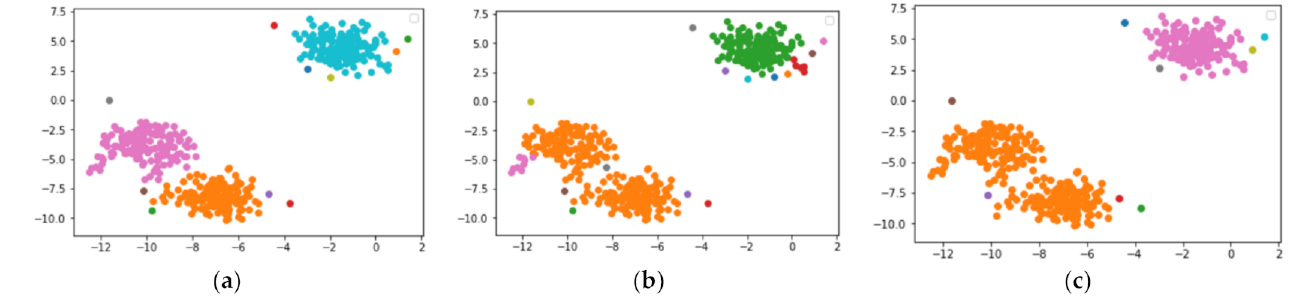
Figure 7. Visual result of proposed method with DM = 1 and ( a ) CS = 0.7, ( b ) CS = 0.6, and ( c ) CS = 0.8.